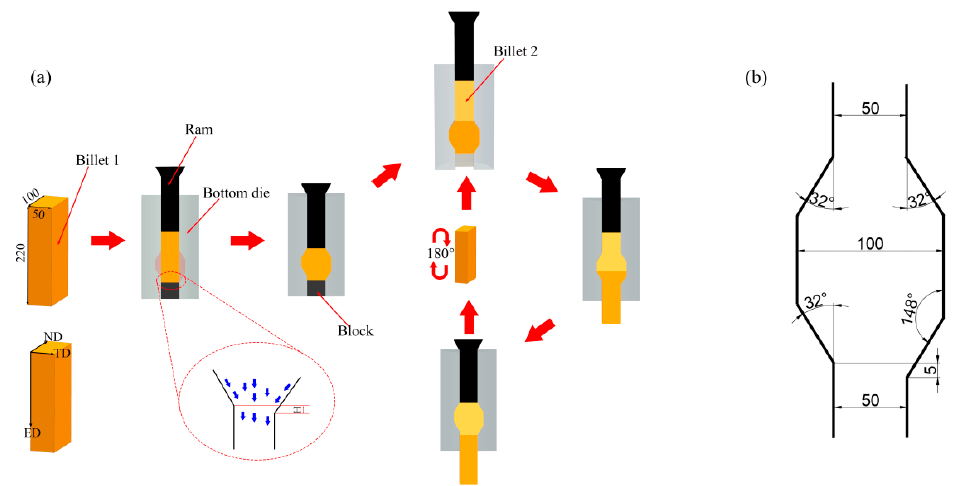
Figure 1. ( a ) The schematic of the cyclic expansion extrusion with an asymmetrical extrusion cavity (CEE-AEC) process; ( b ) the specific parameters of the mold